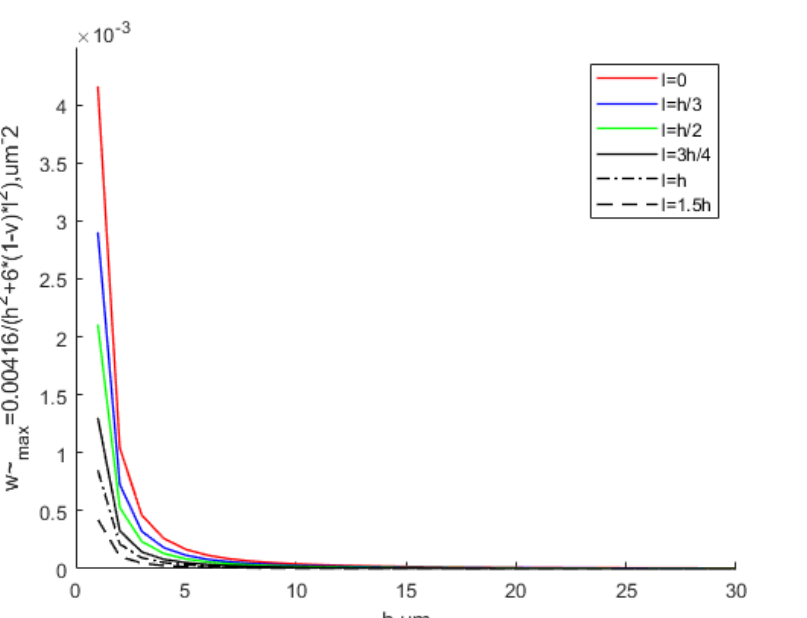
Figure 8. Variation in the equivalent maximum deflection with various values of the scale parameter.